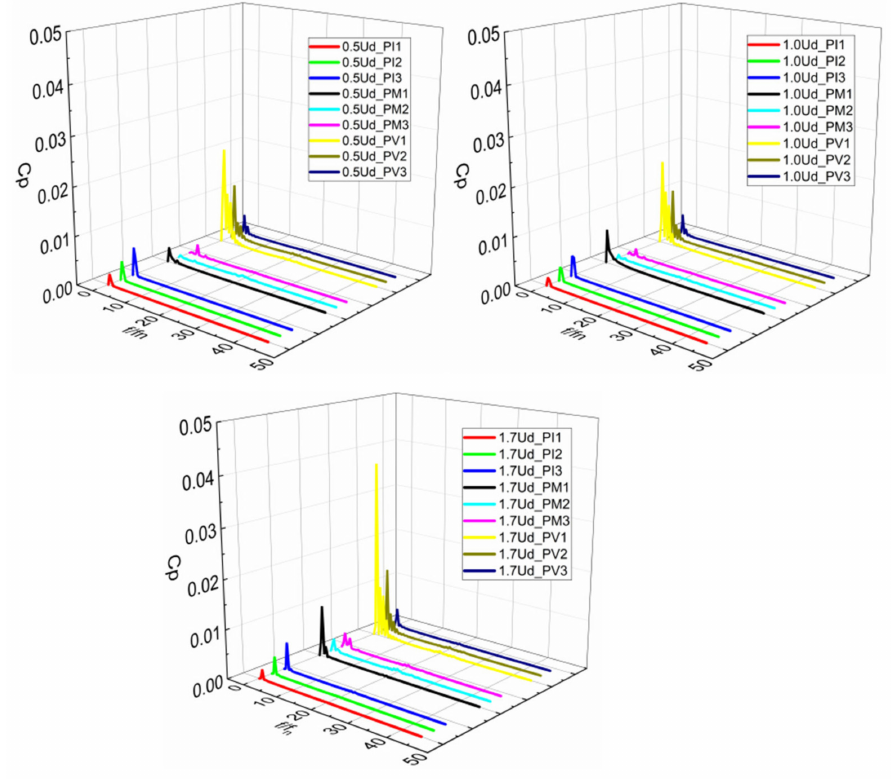
Figure 20. The pressure pulsations on the monitoring